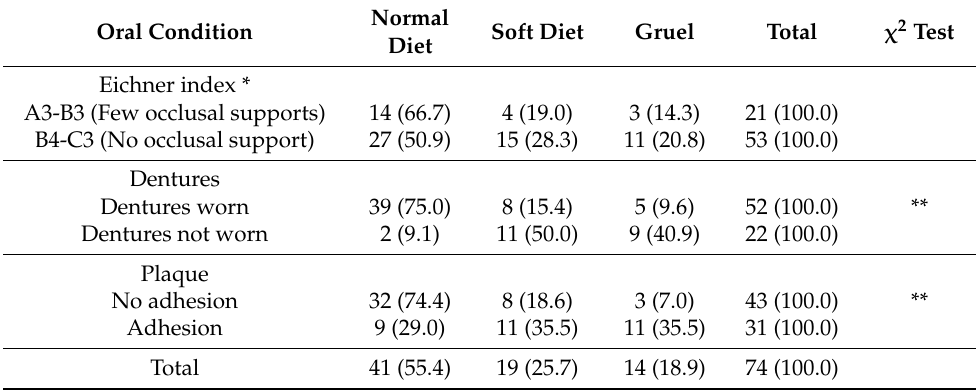
Table 5. Comparison of type of diet and occlusal support zones, denture wearing.